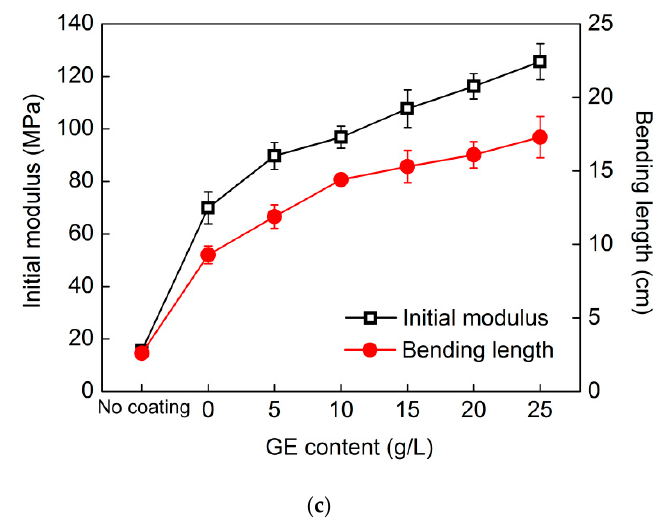
Figure 5. Mechanical properties of nonwoven and composites with various coating agent GE content. ( a ) Tensile curves, ( b ) breaking force and elongation, and ( c ) initial modulus and bending length.